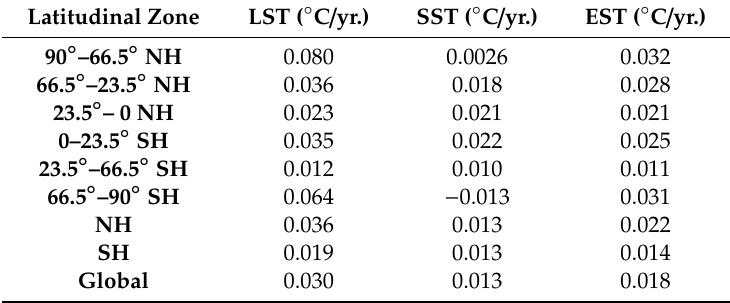
Figure 3. Latitudinal SST (green), LST (orange) and EST (black) evolution in the period 2003–2016. Differences between the three parameters increases with latitude. Table 1. LST, SST and EST linear trends for the 2003–2016 period at a global, hemispherical and latitudinal scale. The LST trend is 0.030 ◦ C / yr., the SST trend is 0.013 ◦ C / yr. and the EST trend is 0.018 ◦ C /